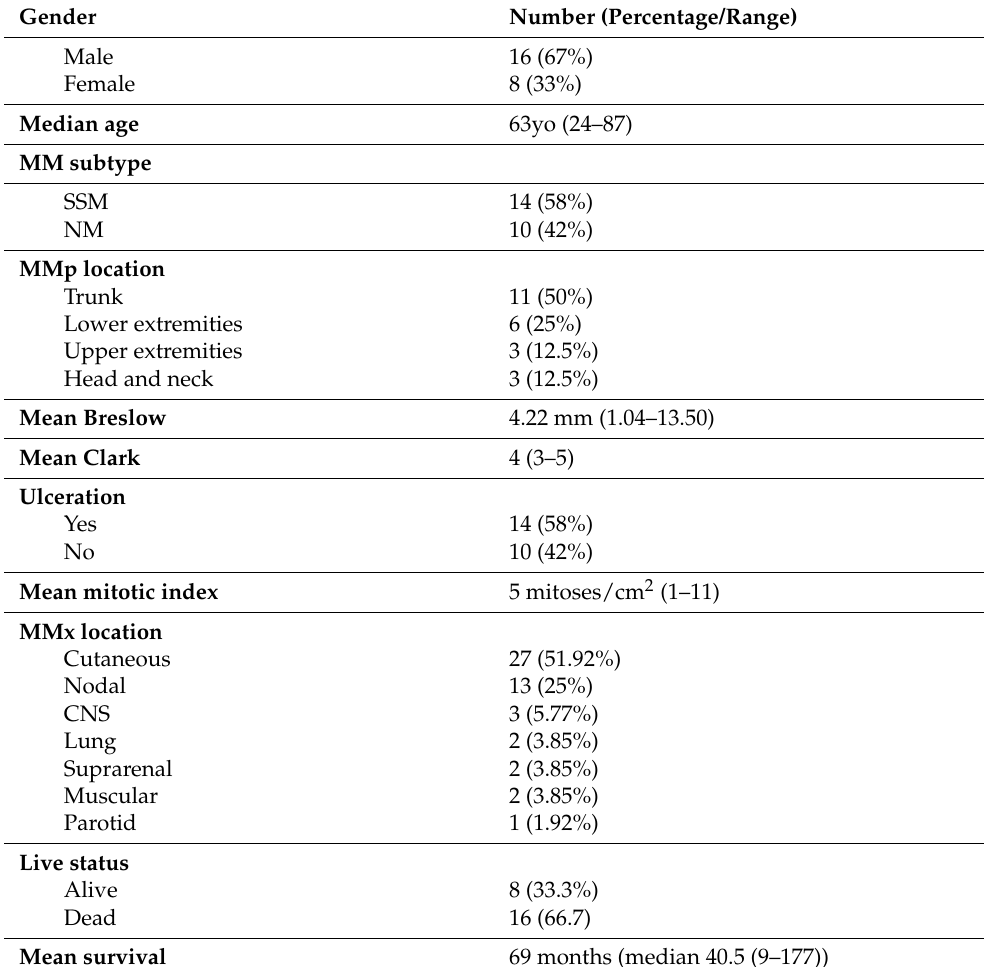
Table 1. Clinicopathological